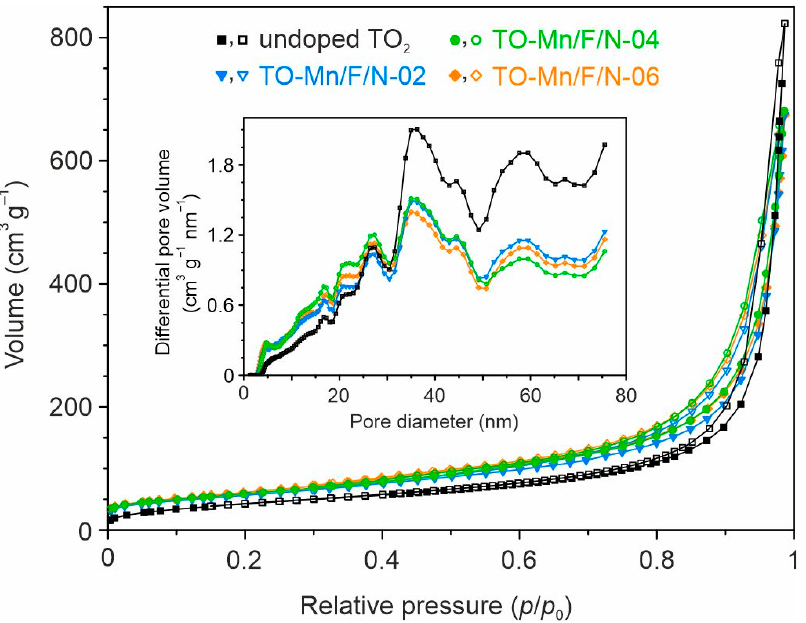
Figure 3. Nitrogen adsorption–desorption isotherms and pore size distribution curves (inset) for the undoped and Mn, F, N co-doped TiO 2 structures (the filled and open symbols represent, respectively, the adsorption and desorption data).